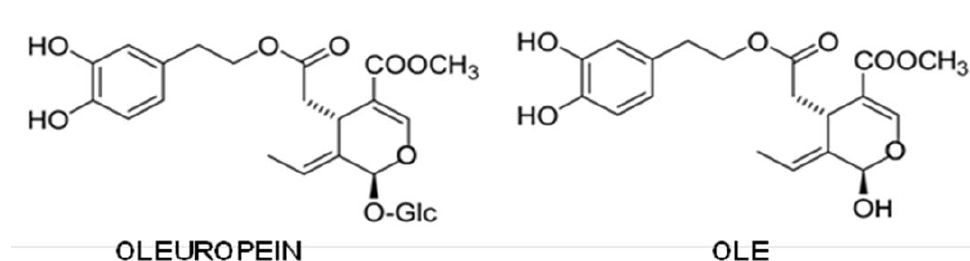
Figure 5. Oleuropein and oleuropein aglycone (OLE)